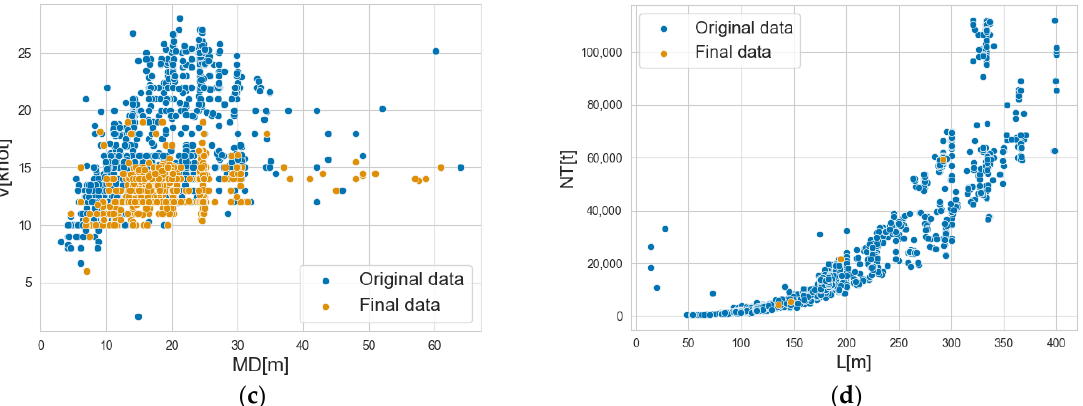
Figure 12. Comparison between the original data (blue dots) and final data (orange dots): ( a ) L, ( b ) AEP, ( c ) V, and ( d ) NT.